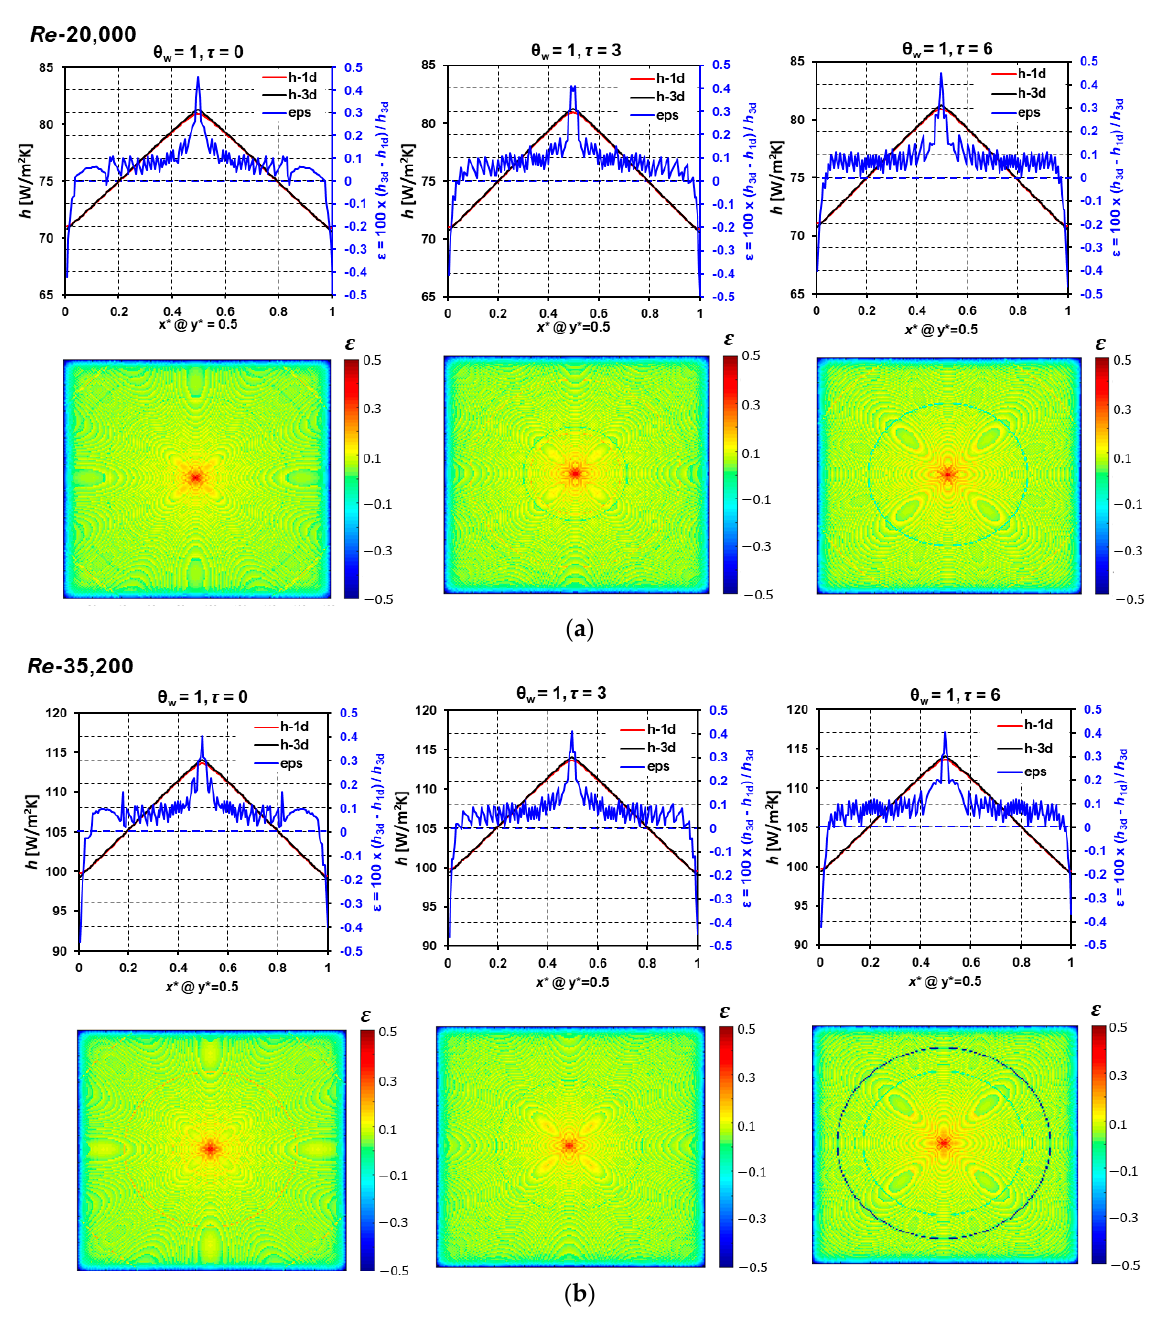
Figure 4. Method A, Case I: Local h variation at surface centerline and their relative % differences, ( a ) Re = 20,000, ( b ) Re = 35,200.